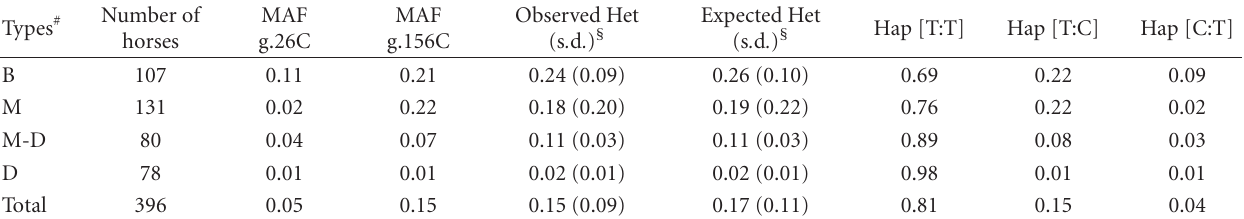
Table 4: Minor allele frequency (MAF), observed and expected heterozygosity (Het ∗ ), and haplotype (Hap § ) frequencies of the two promoter SNPs of the MSTN gene in horses with di ff erent morphological